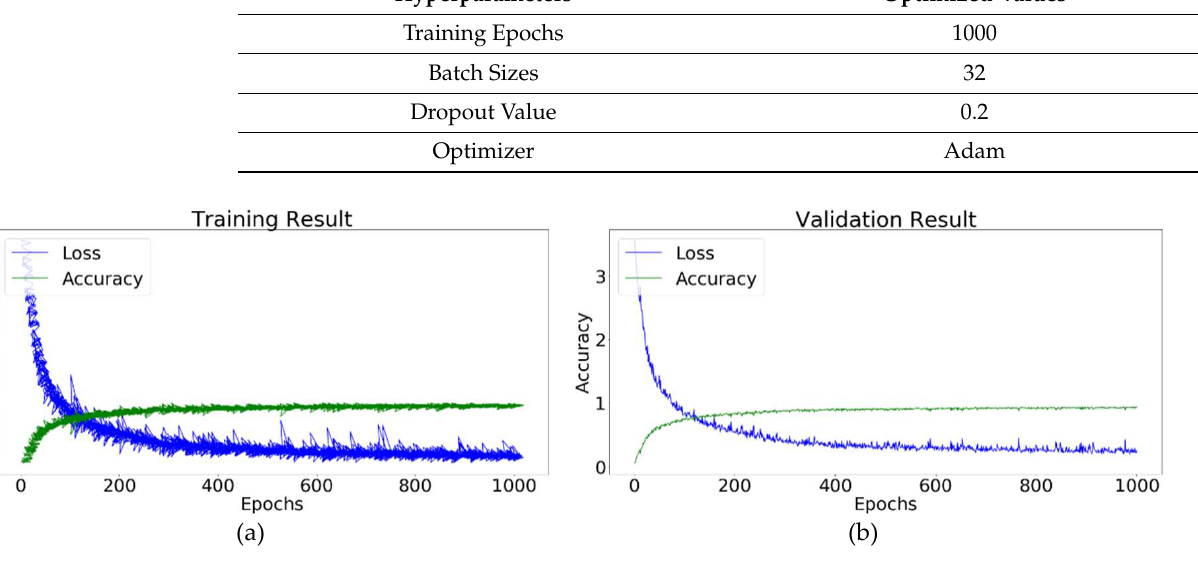
Figure 15. Conv-5 DCNN model: ( a ) Training result; ( b ) validation result.